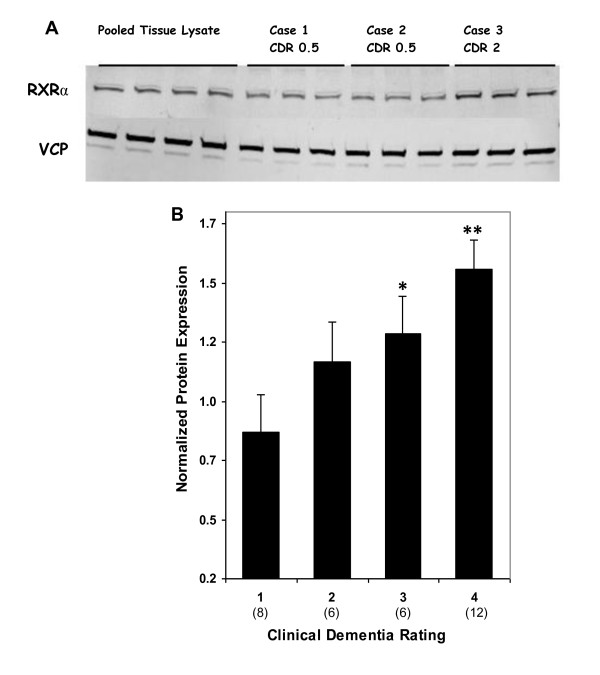
Western blot analysis of RXRα in the hippocampus of cognitively intact controls and subjects with varying severity of dementia. A, Representative immunoblots of RXRα protein expression are shown. Total tissue homogenates were separated by reducing SDS-PAGE and probed with rabbit anti-RXRα and mouse anti-VCP antibodies. Tissue lysate from each subjects were loaded in triplicate and pooled tissue lysate (first 4 lanes) were run in quadruplicates. B, Protein quantification was done by assessing the ratio of RXRα and VCP signal. Mean values ± SEM are shown. *, p < 0.05; **, p < 0.01. Number within the parentheses indicates the individuals within each group.